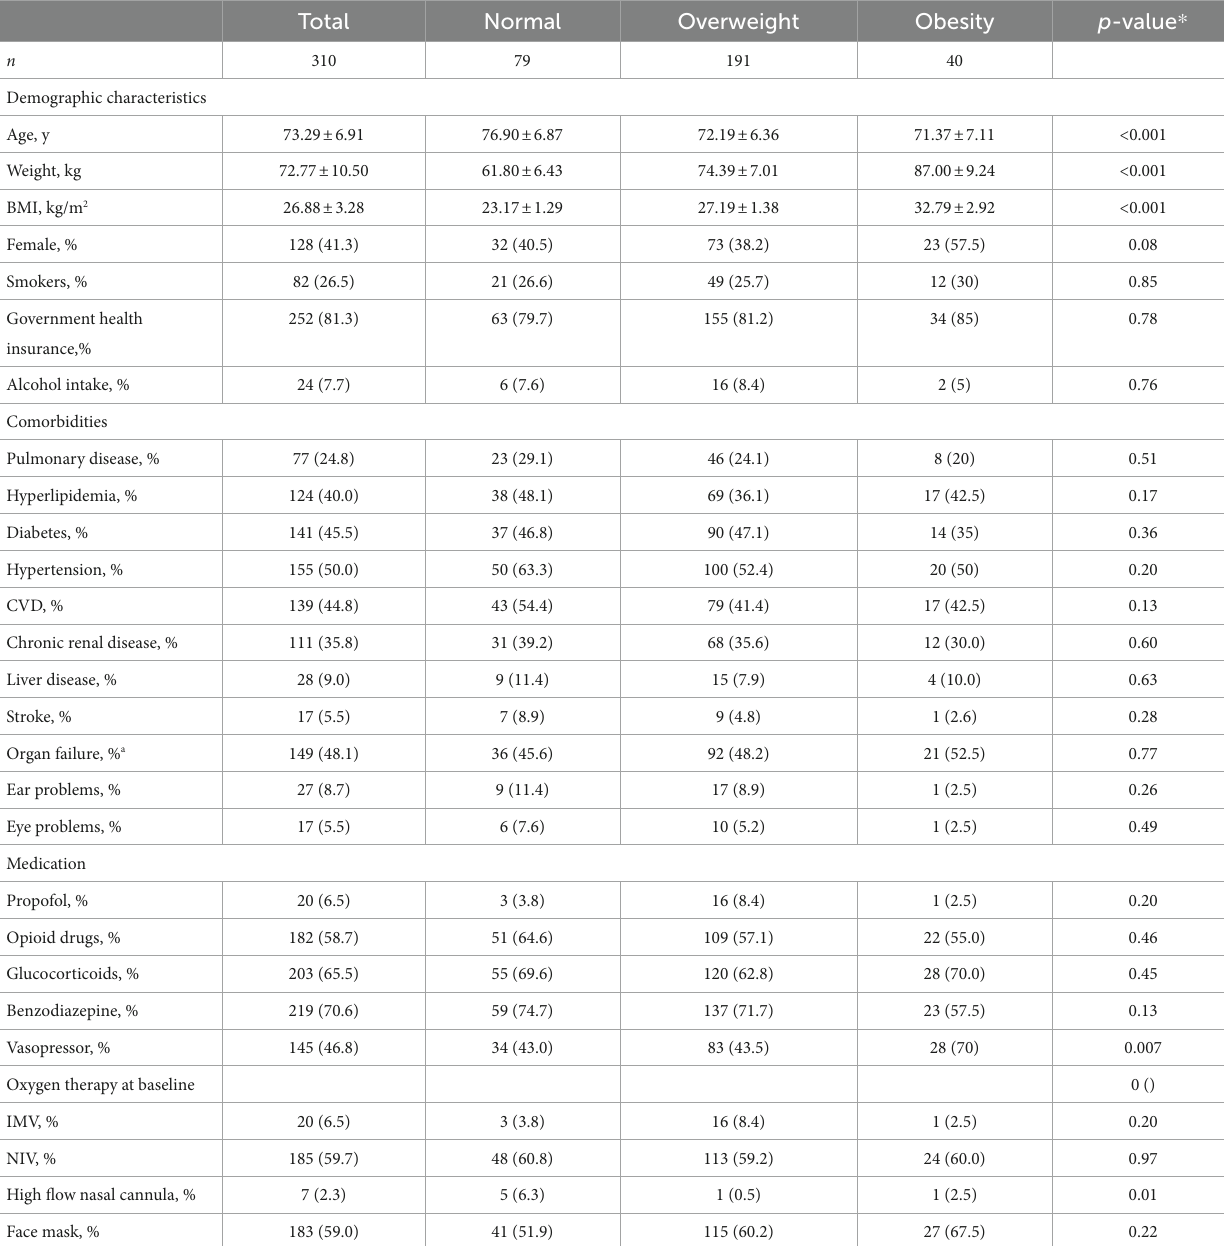
TABLE 1 Baseline characteristics of critically ill elderly patients with COVID-19 across categories of